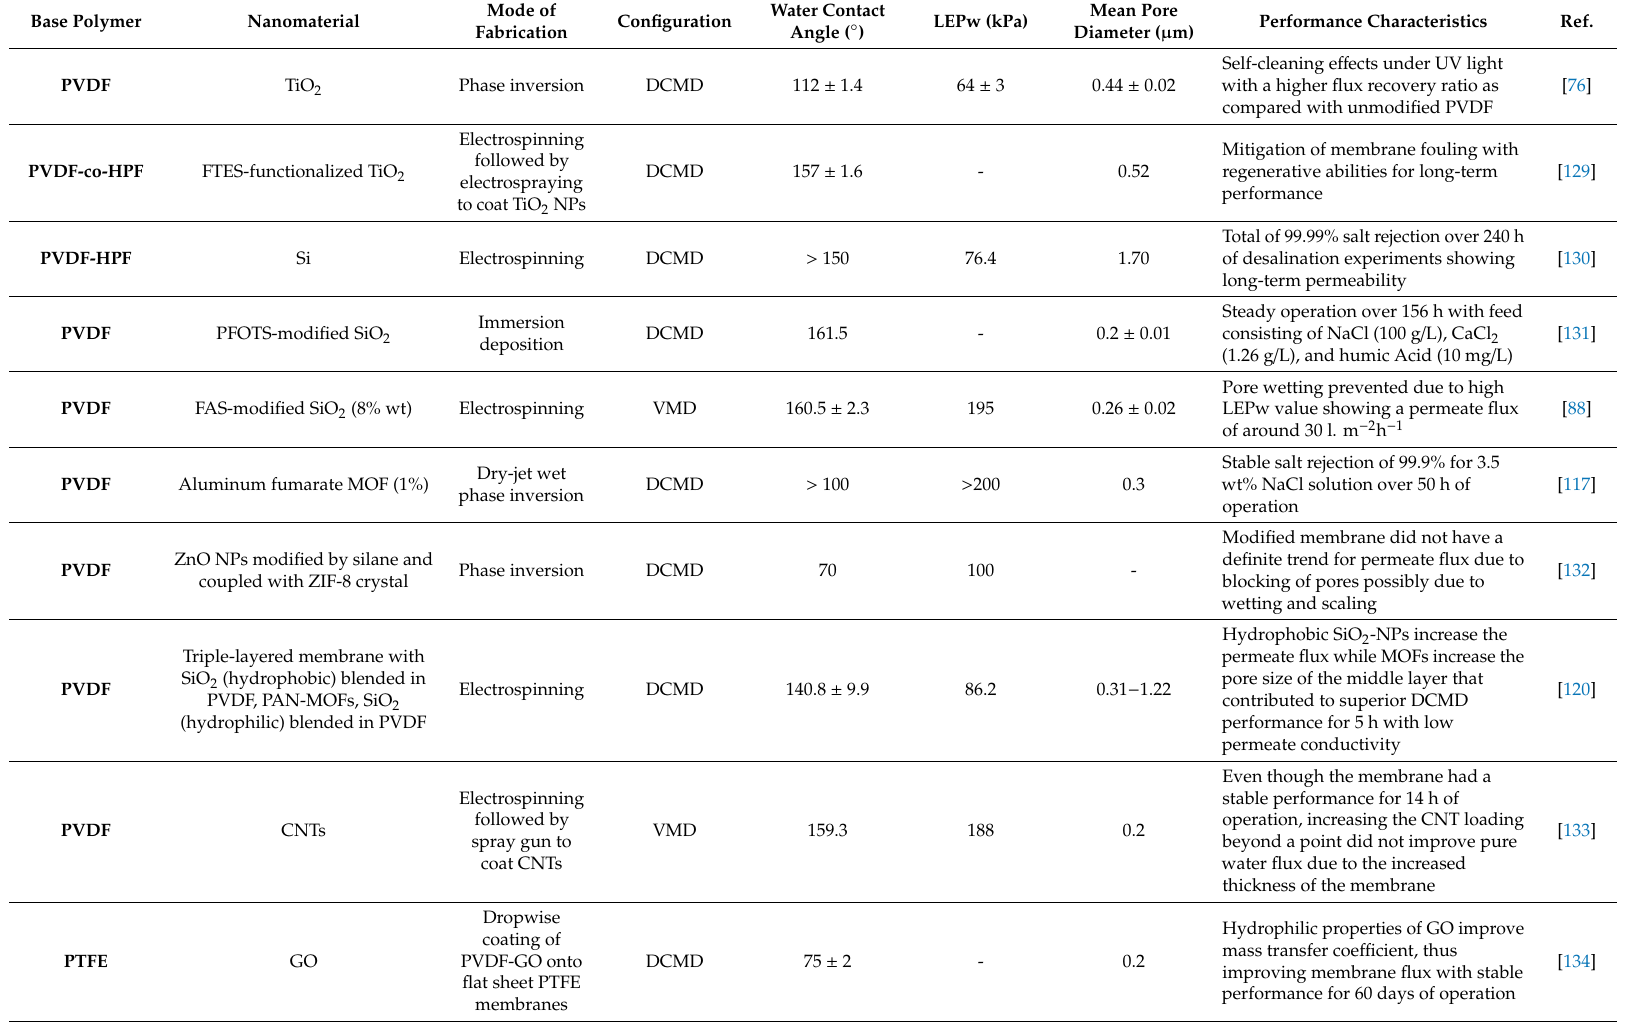
Table 5. E ff ect of nanoparticle addition on anti-wetting and anti-fouling